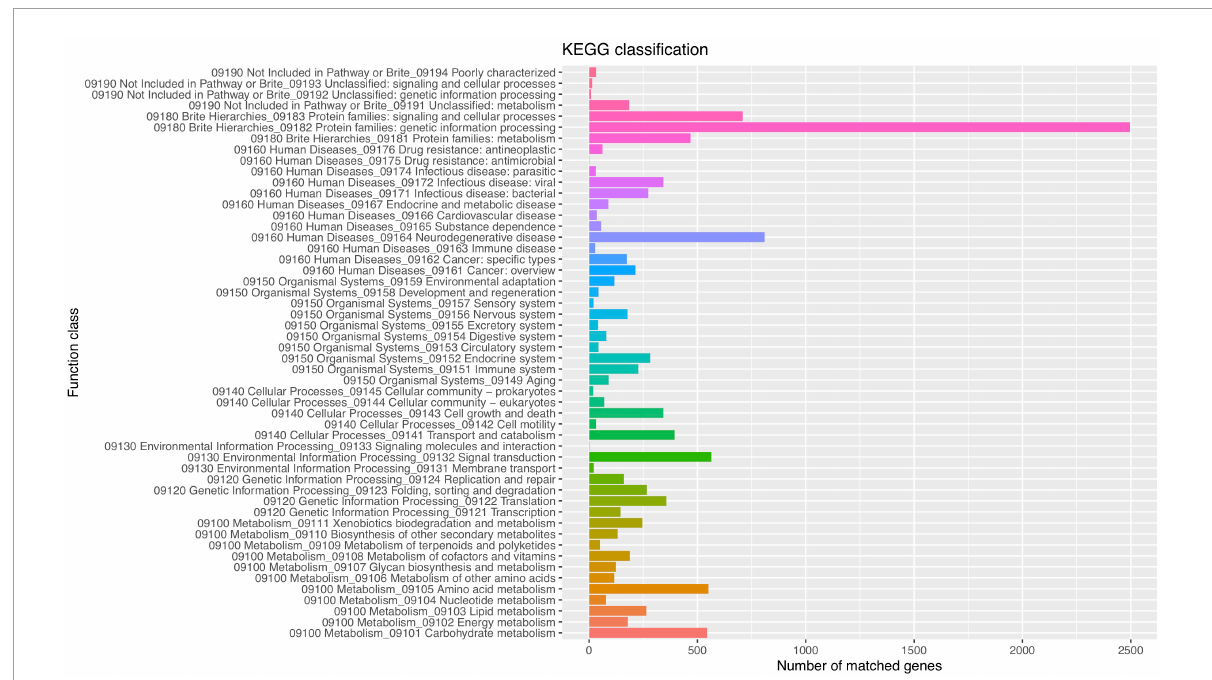
FIGURE3 Kyoto encyclopedia of genes and genomes (KEGG) pathway functional classification of the Penicillium olsonii WGH5 genome.